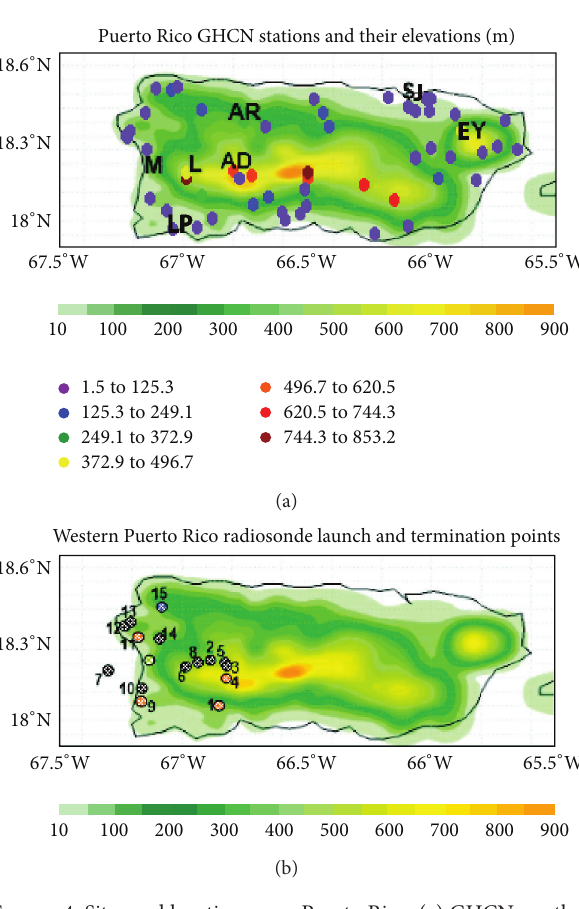
Figure 4: Sites and locations over Puerto Rico. (a) GHCN weather station locations and important city sites. Mayag¨uez (M), Lares (L), Arecibo (A), Adjuntas (AD), San Juan (SJ), and El Yunque (EY) are denoted by the letters M, L, AR, AD, S, and Y, respectively. (b) Radiosonde launch and termination points. The black circle with the green “x” denotes the radiosonde launch site, black circles with orange crosshatching denote the 0800 AST launch termination points, black circles with black crosshatching denote 1100 AST termination points, and the black circle with blue crosshatching denotes the 1500 AST termination point. Table 3: RAMS